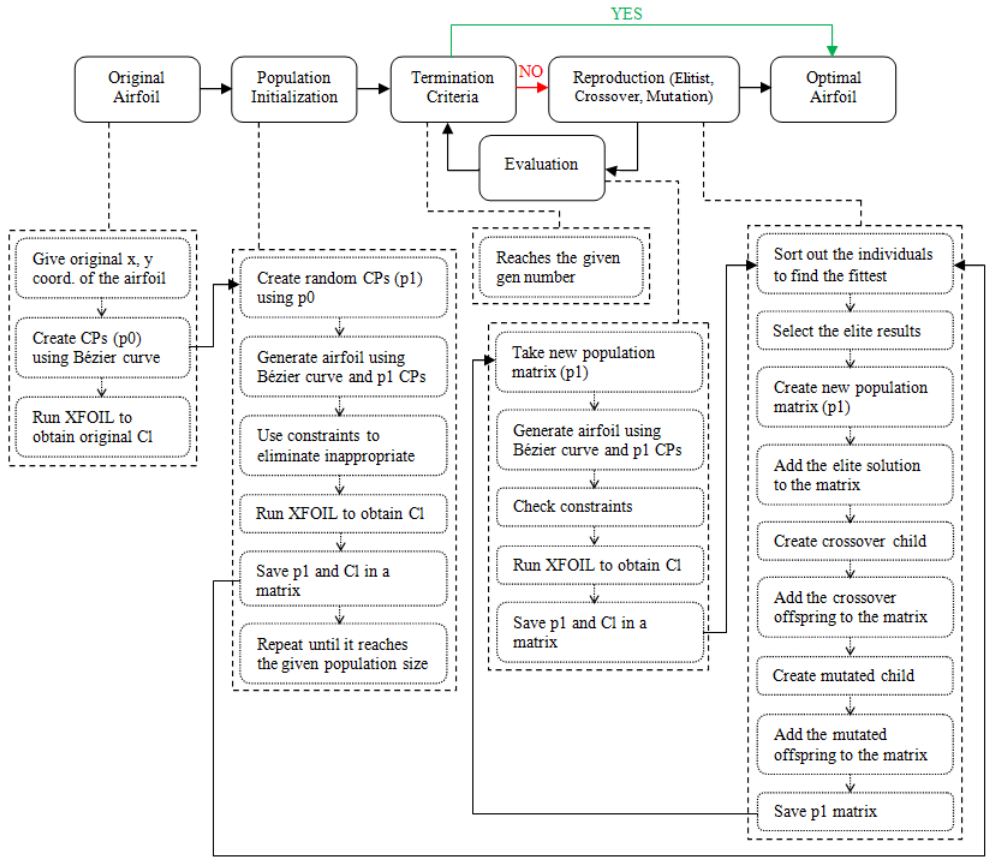
Figure 1. Genetic algorithm